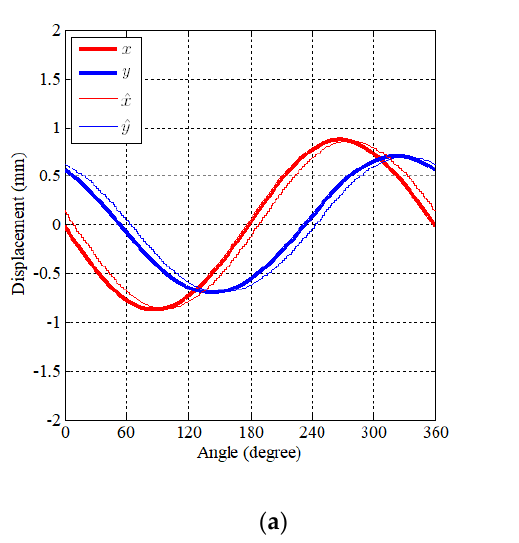
( b ) Figure 13. Effect of compensated  ( a ) without compensation and ( b ) with compensation.  Simulation results of reciprocating motion with a resonant operation are shown in Figure 14. Reference stroke and angle were inputted into the controller as  2mm,  0mm, and  35°. Figure 14a indicates three-phase voltage which represents the fundamental waveform of the PWM. In Figure 14b, three-phase current waveform is illustrated. Each phase current contains some ripple component due to SVPWM. The reciprocating motion can be realized by two-phase currents with the same phase and one phase current with the phase difference of 180°. The amplitude and phase of each phase current are determined by the stroke and direction of the reciprocating motion. Figure 14c indicates the result of displacement ( x  , y  ), stroke (  ,  ), and angle error (  . It was confirmed that the displacement and stroke in the rotating frame converge into  within a period of six cycles, while 